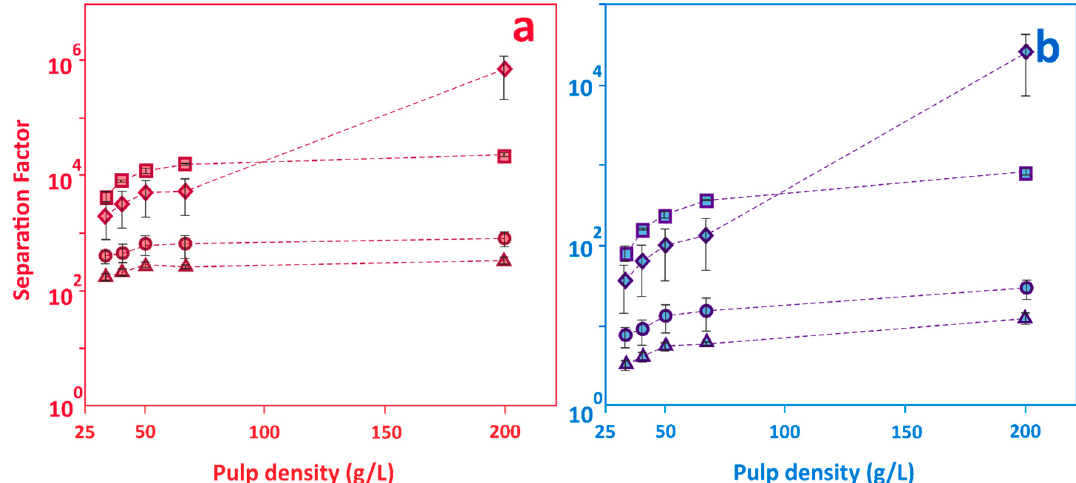
Figure 9. Separation factor of ( a ) Zn: [Zn]/[Fe], [Zn]/[Al], [Zn]/[Mg], [Zn]/[Ca] and ( b ) Cu: [Cu]/[Fe],